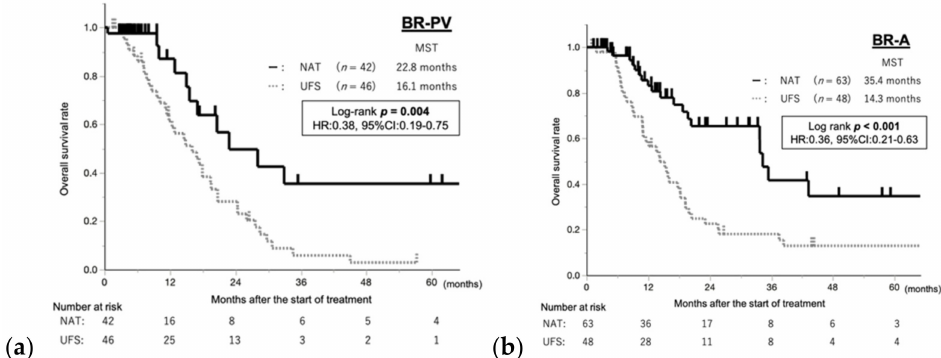
Figure 2. The overall survival in comparison between patients treated with and without NAT in the ( a ) BR-PV and ( b ) BR-A groups. The prognosis of patients treated with NAT was significantly better than that of patients treated without NAT in the BR-PV and BR-A groups ( p = 0.004 and p < 0.001). NAT, neoadjuvant treatment; UFS, upfront surgery; MST, median survival time; HR, hazard ratio; CI, confidence interval.